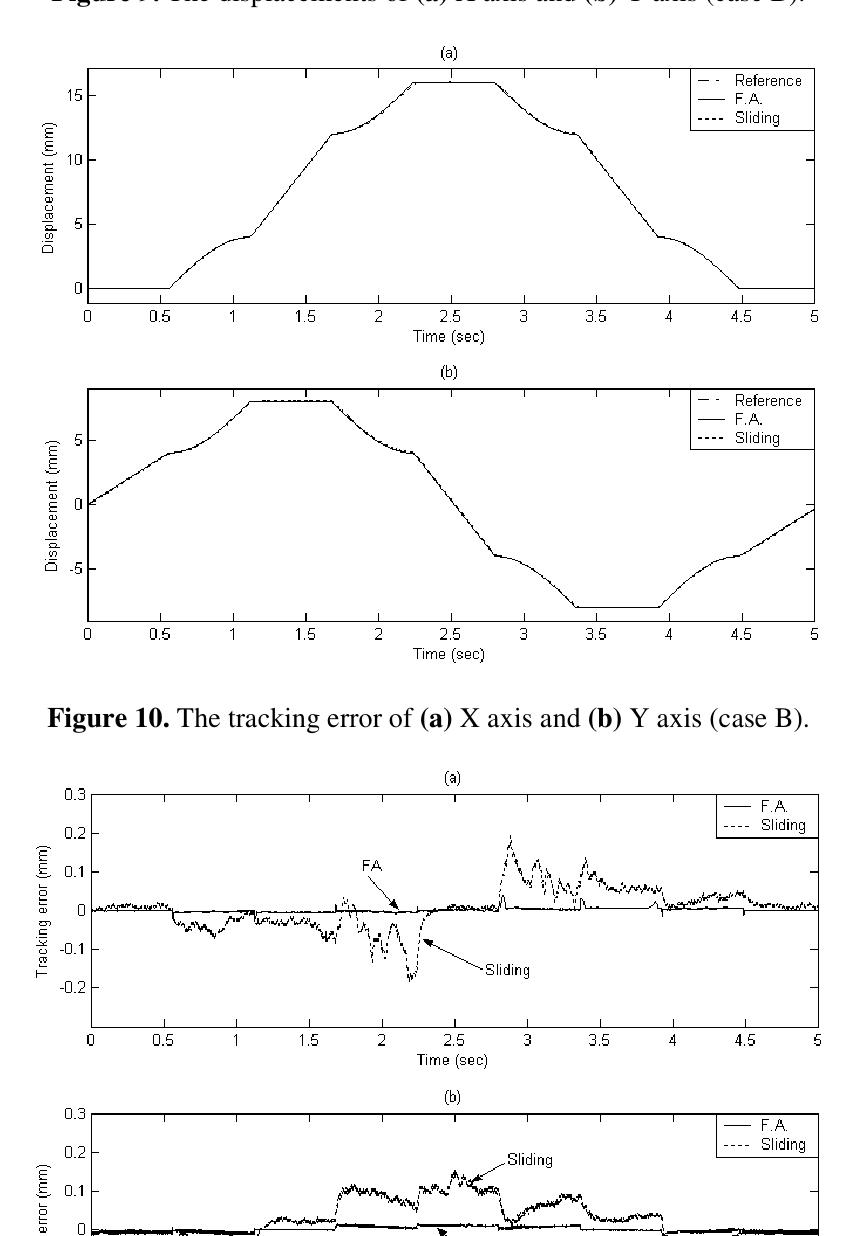
Figure 9. The displacements of (a) X axis and (b) Y axis (case B).